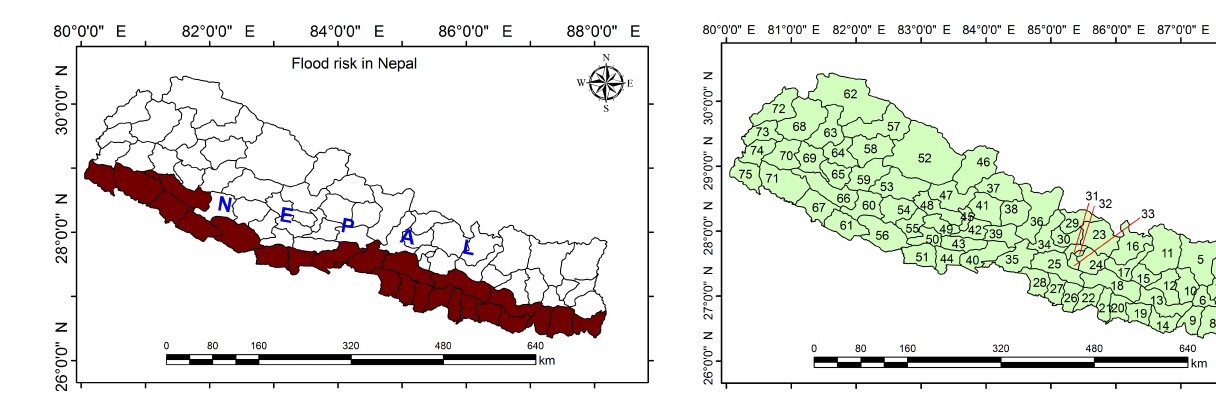
Figure 1. Generalized flood risk map for Nepal.